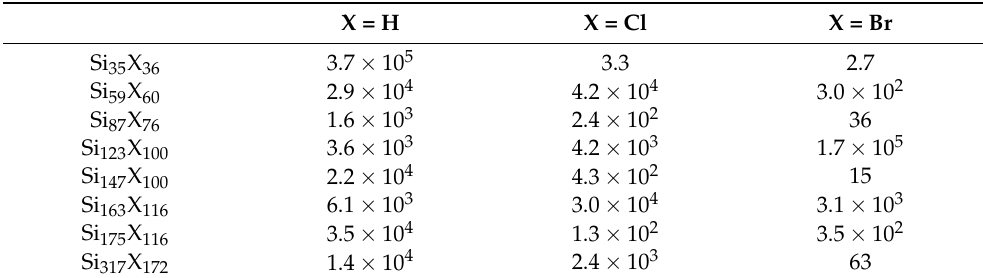
Table 1. Calculated rates (s − 1 ) of the radiative HOMO–LUMO transitions in H-, Cl- and Br-passivated silicon